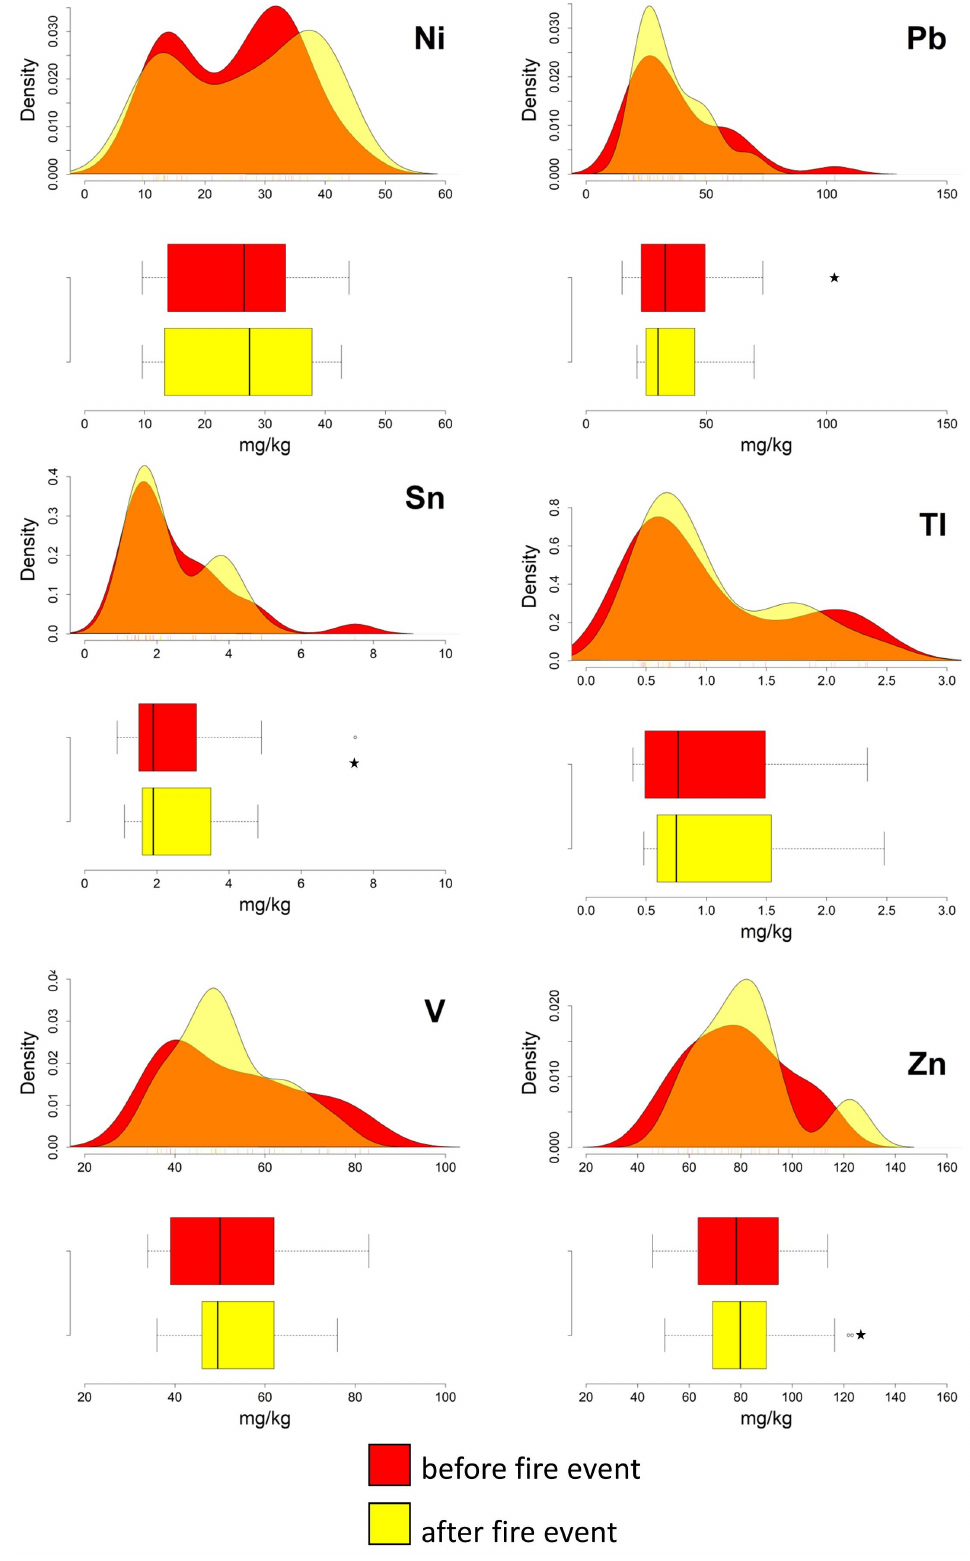
Figure 3. Figure 3. Ilside site. Boxplots and density curves of selected PTEs (Ni, Pb, Sn, Tl, V, and Zn) in the soil before and after the fire event. Circles and pentagrams represent outliers and extreme values,